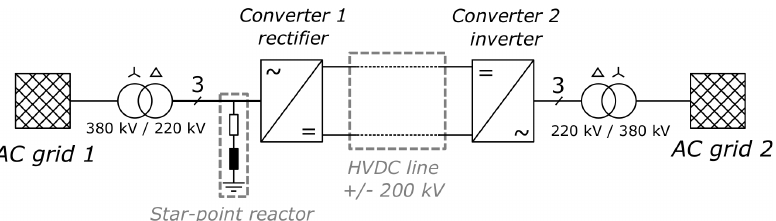
Figure 1. Overview of the symmetric monopole high-voltage direct-current (HVDC) link; Converter 1 operates as a rectifier and Converter 2 operates as an inverter.